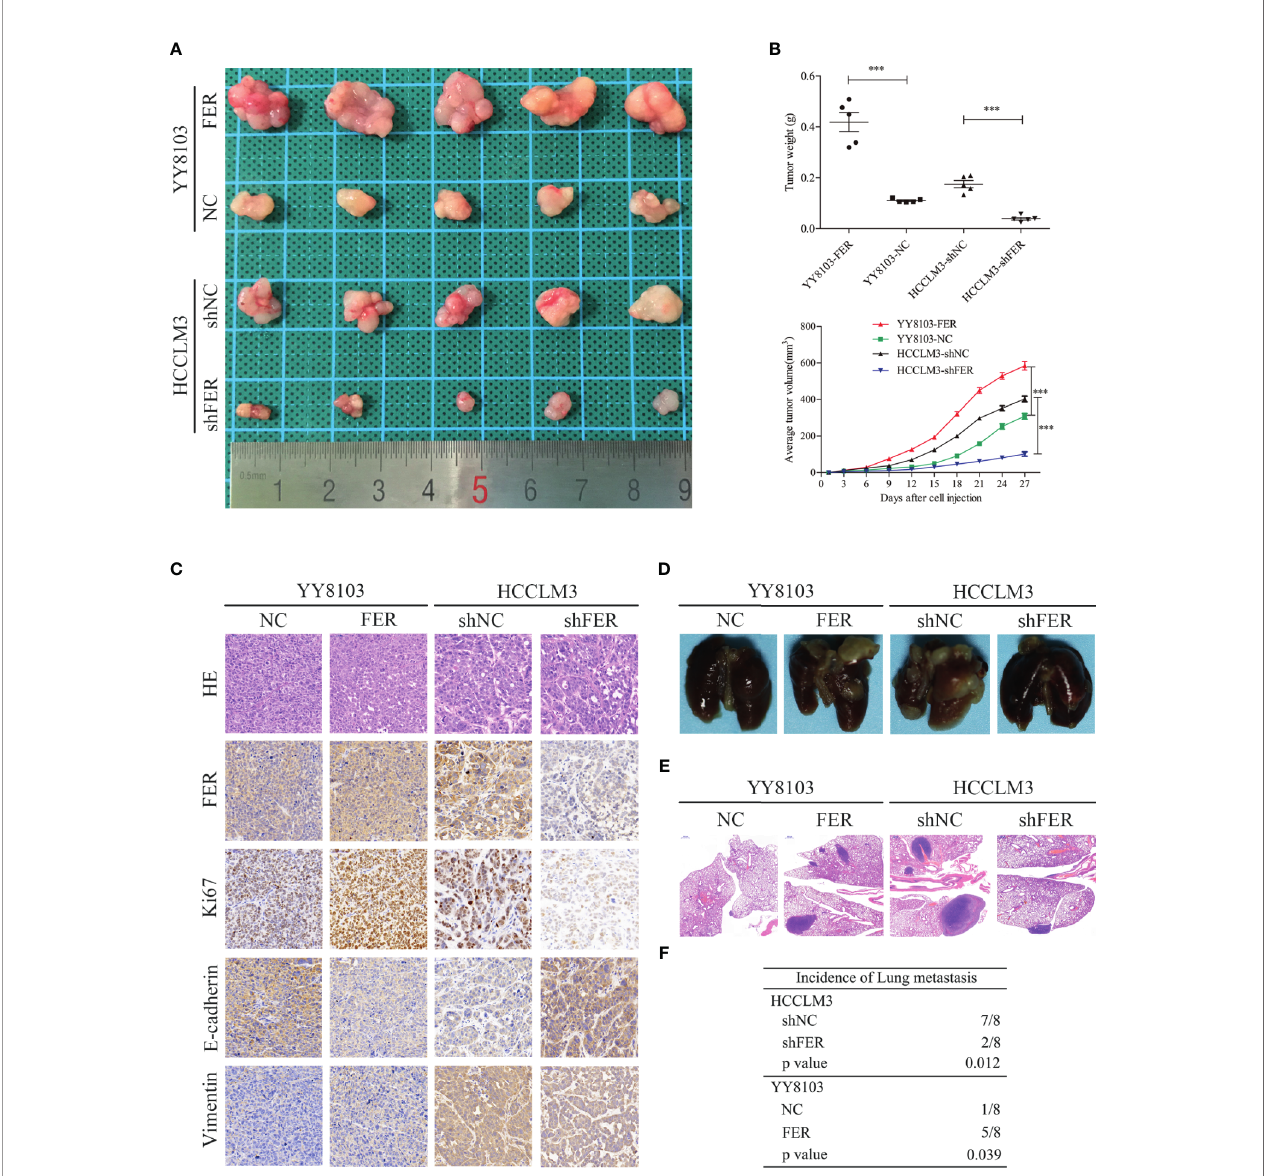
FIGURE 4 | FER increase HCC growth and metastasis in vivo . (A) Representative images of subcutaneous tumor tissues derived from the indicated HCC cells. (B) Tumor weight and volume from the four groups were recorded and analyzed. (C) Representative images of HE staining and immunohistochemical analysis of the FER, Ki-67, E-cadherin and Vimentin protein levels in the subcutaneous tumor tissues from four groups (400x). (D) Representative images of the indicated groups of the pulmonary metastasis model. (E) Representative HE staining images of lung tissues from the four groups (20x). (F) The incidence of pulmonary metastasis in the four groups was statistically analyzed. (***P <